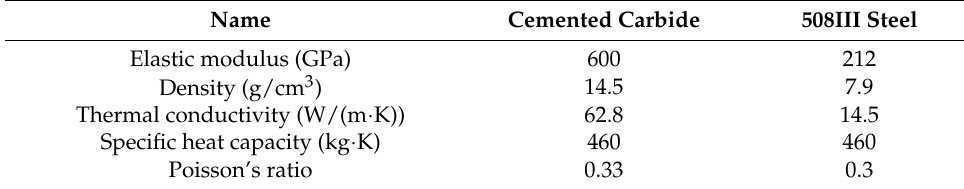
Table 2. Parameters of tool and workpiece materials.